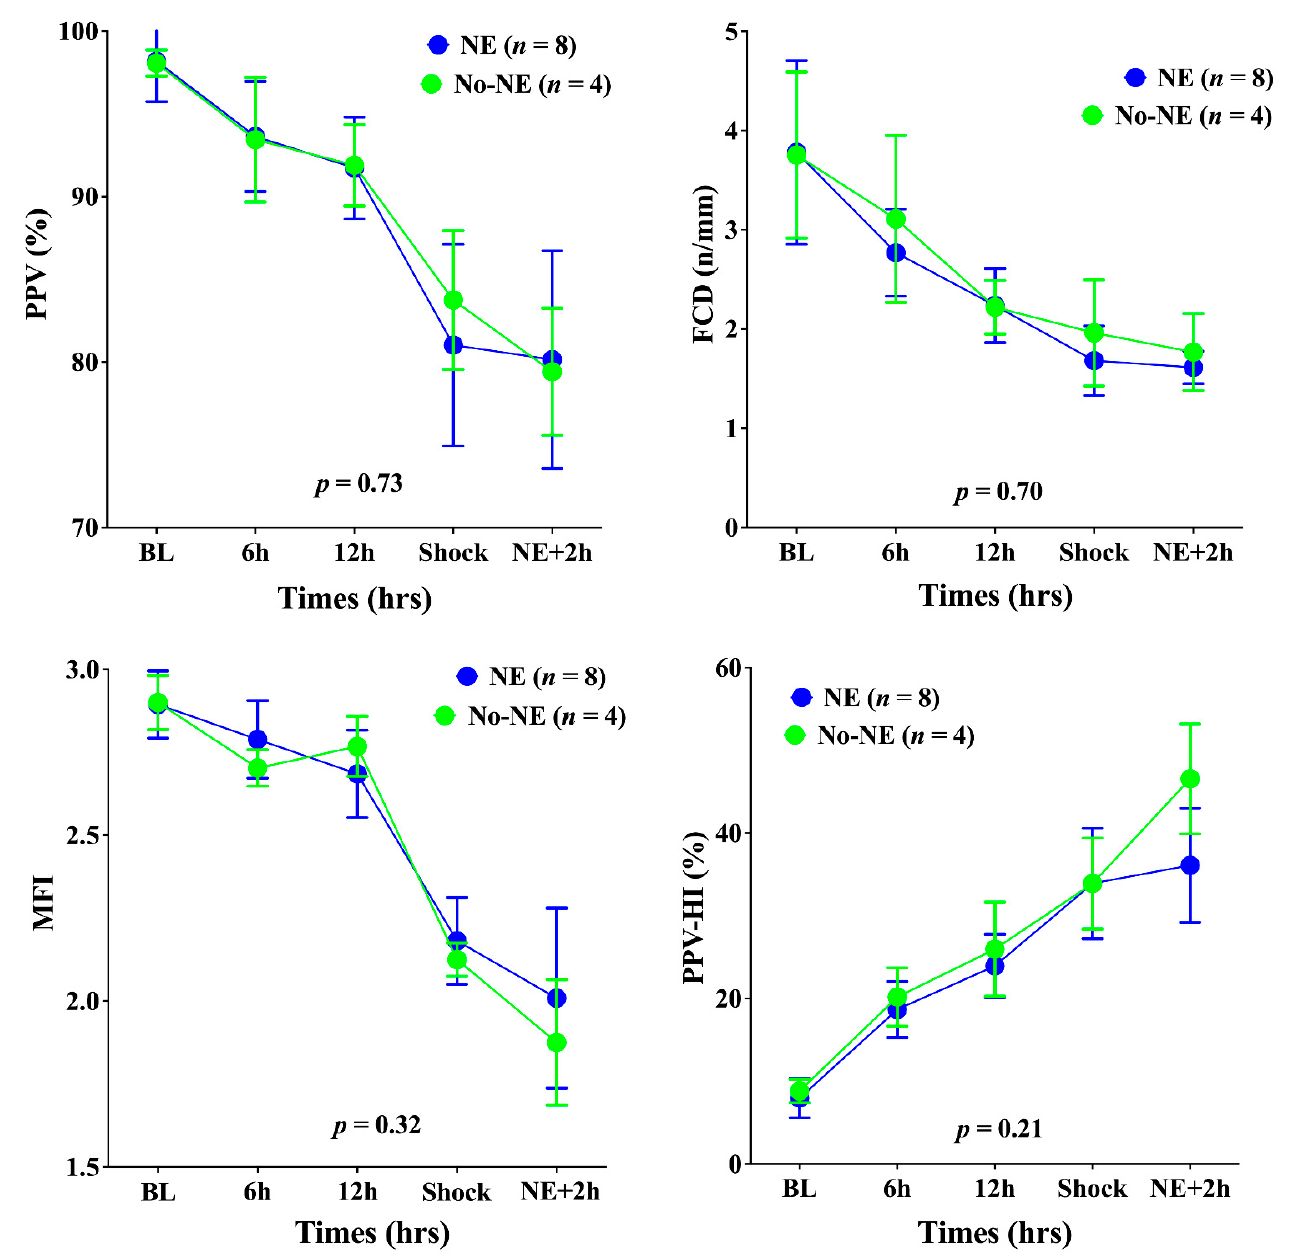
Figure 2. Time-course of the proportion of small perfused vessels (PPV), the functional capacity density (FCD), the mean flow index (MFI), and the heterogeneity index of PPV (PPV-HI) in the cerebral microcirculation in the two groups of animals. NE, norepinephrine. Data are presented as mean ± SEM.